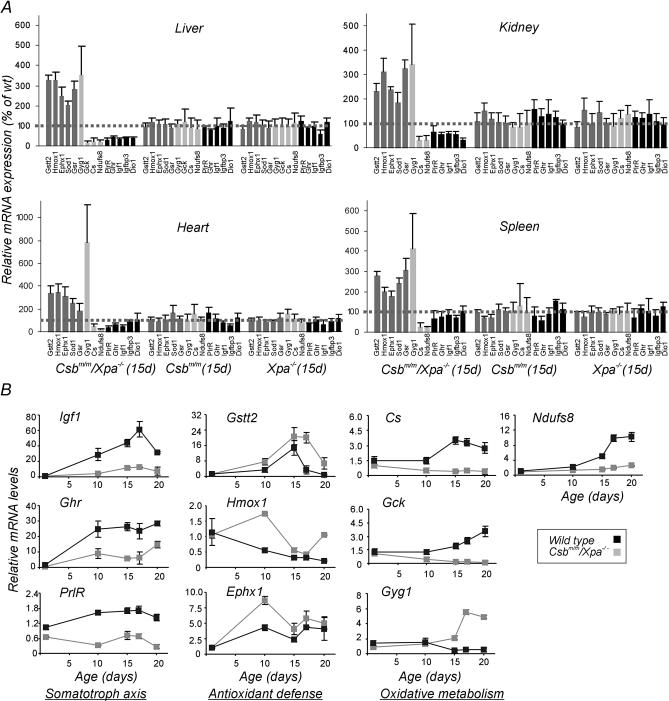
Expression Levels of Genes Associated with the Somatotroph Axis, Antioxidant Defense, and Metabolism in Mutant and wt Mouse Liver and Other Organs at Various Ages
(A) Q-PCR evaluation of mRNA levels of genes associated with antioxidant defense (dark gray bars), oxidative metabolism (light gray bars), and the GH/IGF1 axis (black bars) in the liver, kidney, heart, and spleen of 15-d-old Csbm/m/Xpa−/−, Csbm/m, and Xpa−/− pups. For each gene, expression levels in the mutant tissue are plotted relative to that of age-matched wt control tissues (dotted line). Error bars indicate SEM between replicates (n ≥ 3).(B) Relative mRNA expression levels (fold changes, relative to embryonic day 18) of genes involved in the GH/IGF1 growth axis, antioxidant defense, and oxidative metabolism in the liver of wt and Csbm/m/Xpa−/− pups, plotted as a function of time. Error bars indicate SEM between replicates (n ≥ 3).